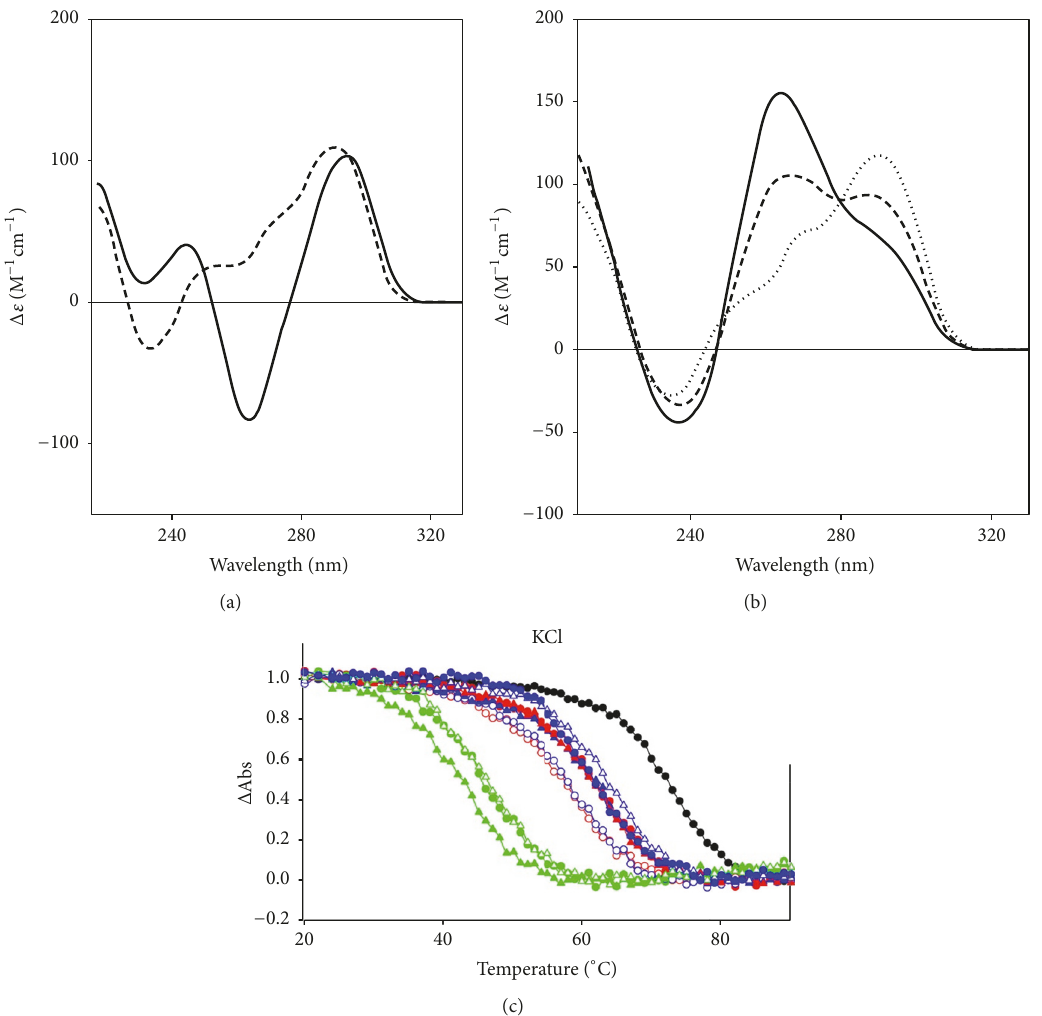
Figure 3: CD spectra of different GQ topologies and a series of thermal unfolding profiles. (a) shows the CD spectra of the antiparallel basket architecture of htel-21 GQ recorded in 100 mM Na + solution and characterized by positive Cotton effects near 295 nm and 240 nm and a negative one around 260 nm (solid line), as well as the polymorphic form adopted by the same oligodeoxynucleotide in 100mM K + , which is a mixture of K + -stabilized antiparallel and the hybrid forms, with the positive ellipticity near 290 nm, a strong shoulder around 270 nm, and a negative one close to 240 nm (broken line). (b) displays, for comparison, the CD spectra of the same K + -stabilized mixture of the htel-21 GQ (dotted line) and the mixture of just the hybrid forms with two positive peaks of close to equal heights at 290 and 260 nm (dashed line), all determined at low (50–100 𝜇 M) DNA strand concentrations, as well as the majority parallel forms adopted at/above 2 mM of the strands (solid line) (see references in [8]). (c) illustrates normalized thermal unfolding profiles of 8-oxoguanine containing htel-21 GQs